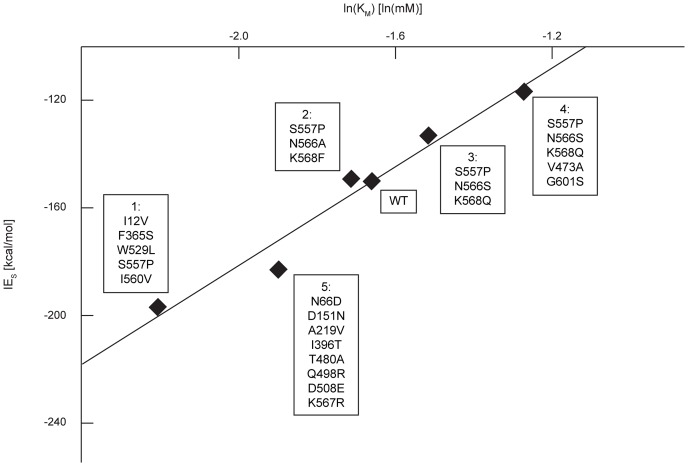
Ground state computational IES for pNP-GLU versus the natural logarithm of experimental KM.IEs were calculated using IPRO, and experimental data was obtained from literature [48], [49], [57]. Each numbered label corresponds to a single variant enzyme with multiple amino acid substitutions from wild-type (WT). Calculated IEs at the ground state are consistent with the observed changes in KM for GUS mutants (R2 = 0.960). Figure S2 shows the distribution of the trajectory-best IEs whose average forms each data point.